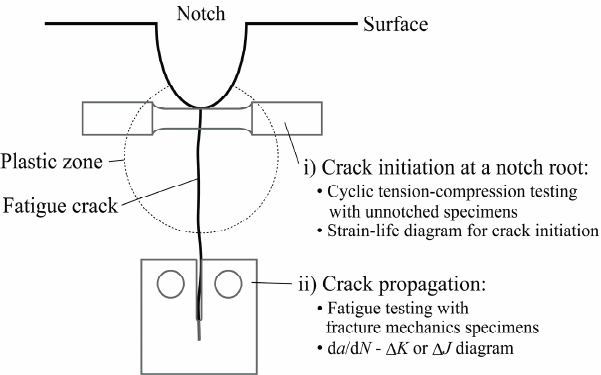
Figure 1. Schematic illustration of fatigue life evaluation for a notched component.